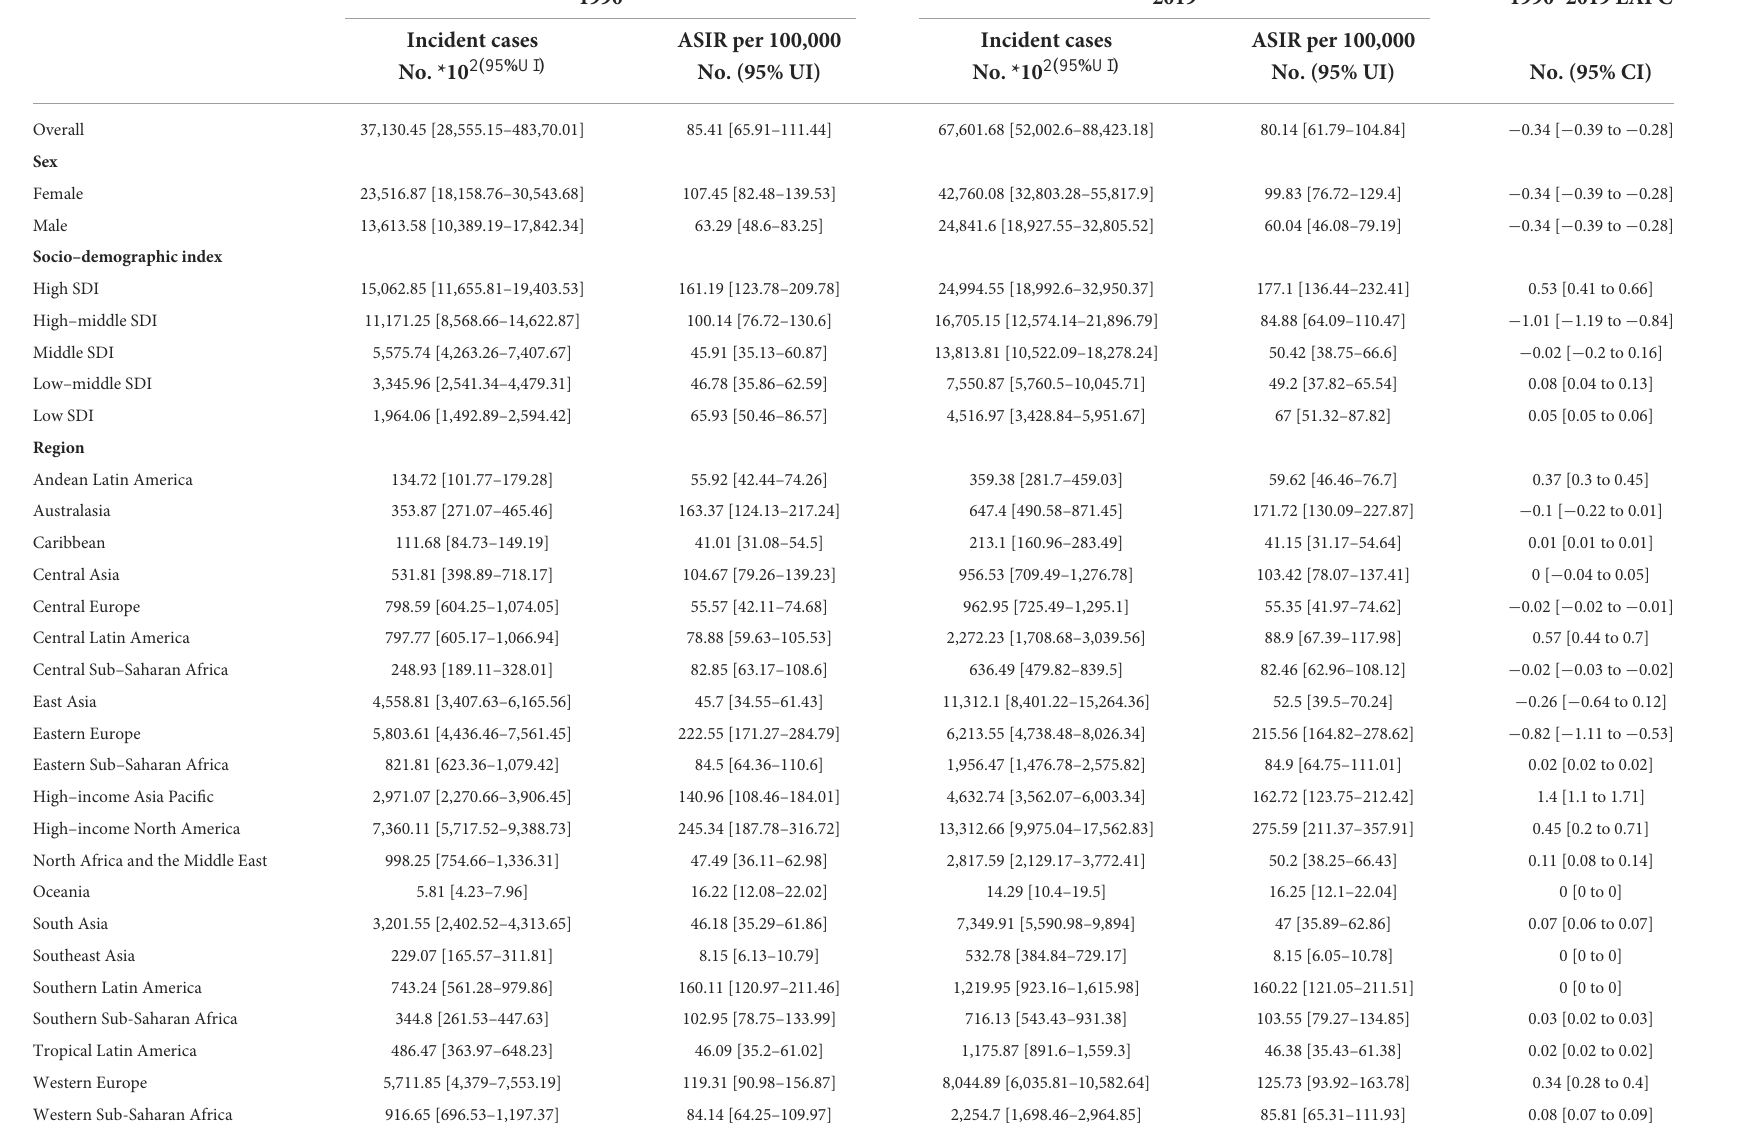
TABLE 1 Incident cases and ASIR in 1990 and 2019 and its current trends from 1990 to